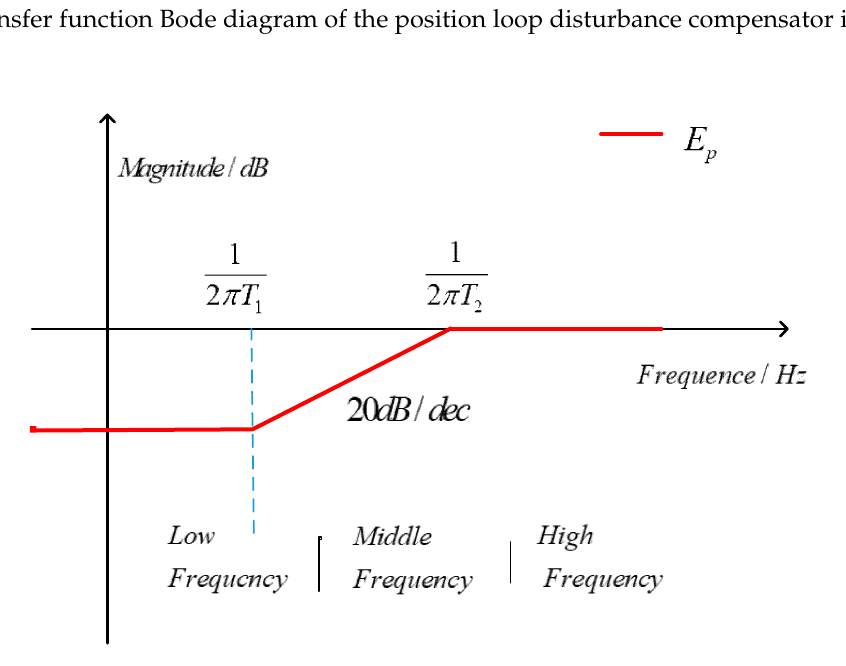
Figure 7. Bode diagram of the disturbance rejection function of the position loop.